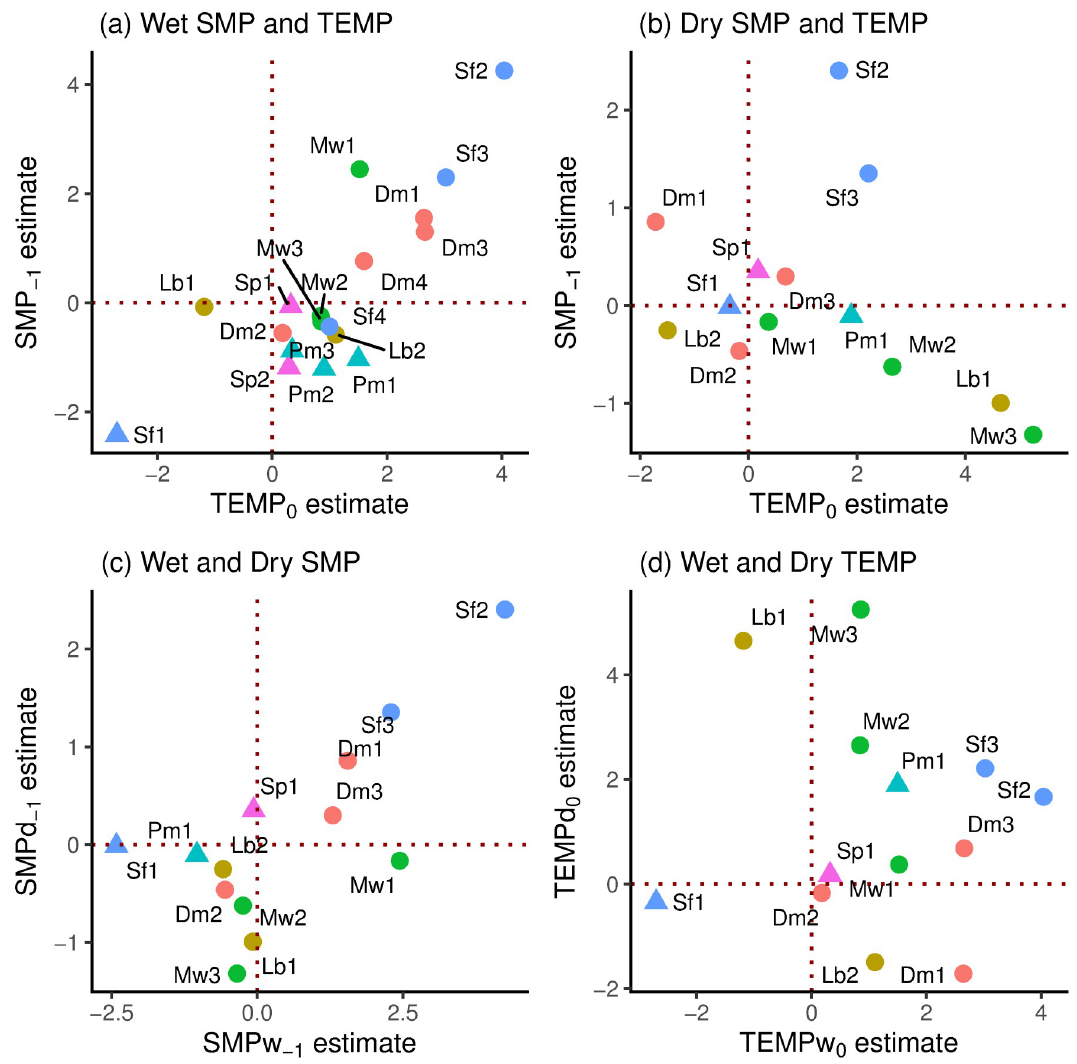
Fig 7. Standardized SMP versus TEMP 0 coefficients in relation to one another. Shown are (a) wet [w] and (b) dry [d] periods for − 1 the 18 respective 13 trees analyzed for their gthi time-series, and their corresponding dry- and wet-period (c) SMP − 1 and (d) TEMP 0 values. Symbols as in Fig